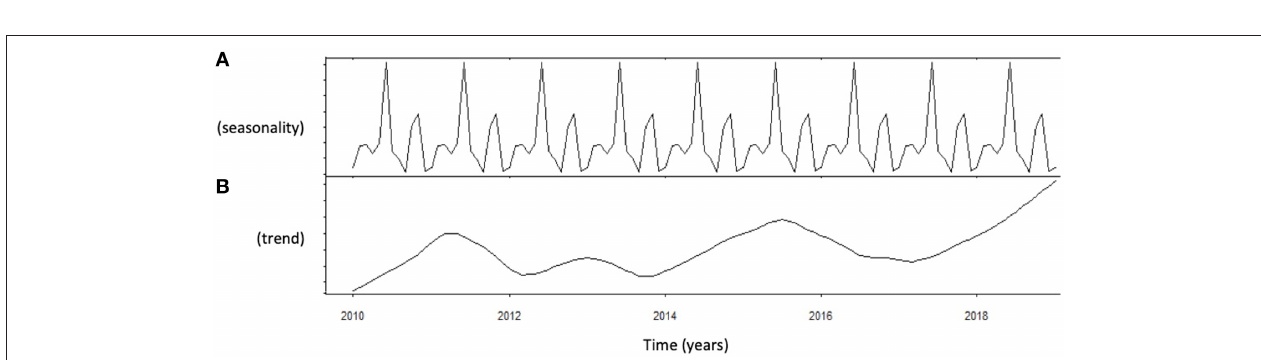
FIGURE 3 | Analysis of luteinizing hormone (LH) levels distribution using autoregressive integrated moving average (ARIMA) model. (A) Shows the data distribution across years, suggesting possible peak and nadir. (B) Shows the trend of data collected across years of observation.